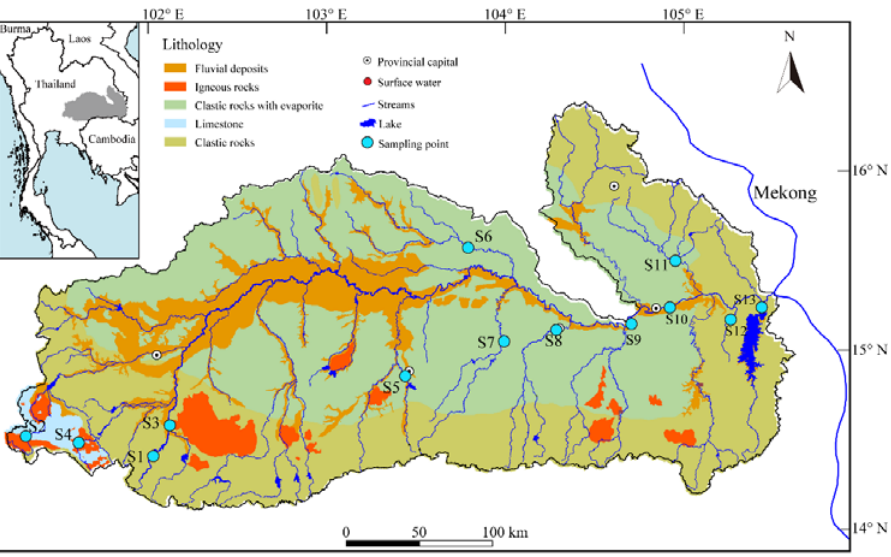
Figure 1. The sampling sites and the different rock types of the Mun River Basin, adapted from Li, Han, Liu, Song, Zhang, Yang and Liu [37] .